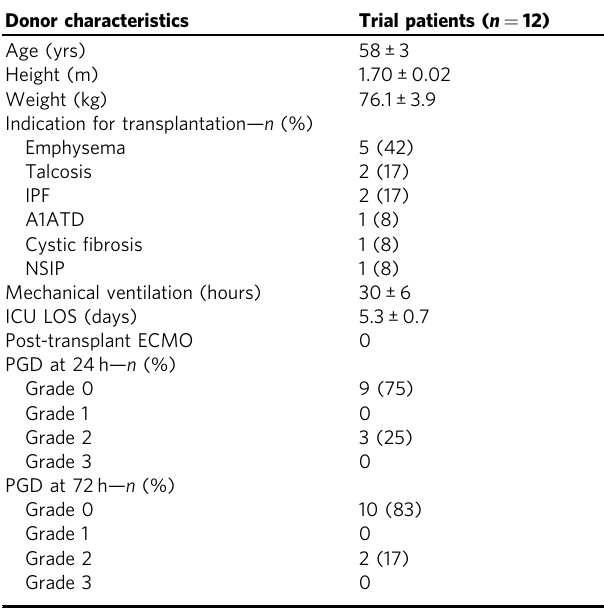
ECMO extracorporeal mechanical oxygenation, ICU intensive care unit, LOS length of stay, PGD primary graft dysfunction, COPD chronic obstructive pulmonary disease, IPF idiopathic pulmonary fi brosis, NSIP nonspeci fi c interstitial pneumonitis, ILD interstitial lung disease, A1ATD alpha-1 anti-trypsin de fi ciency. *Plus – minus values represent